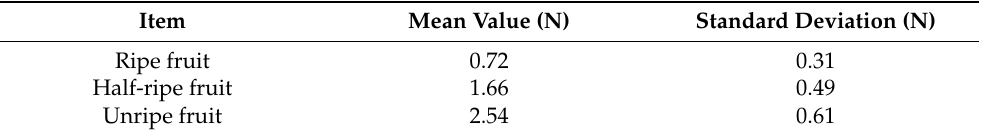
Table 1. The picking forces of